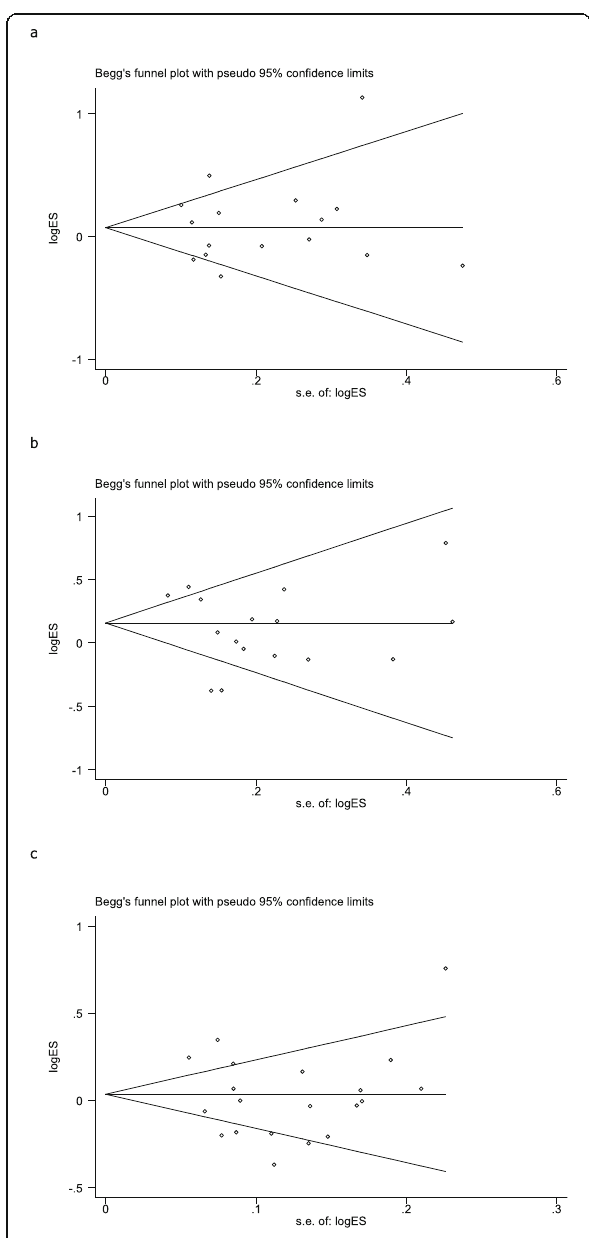
Fig. 4 Begg ’ s funnel plot for publication bias analysis. a The model of CC vs CT + TT. b The model of CC + CT vs TT. c The model of C vs